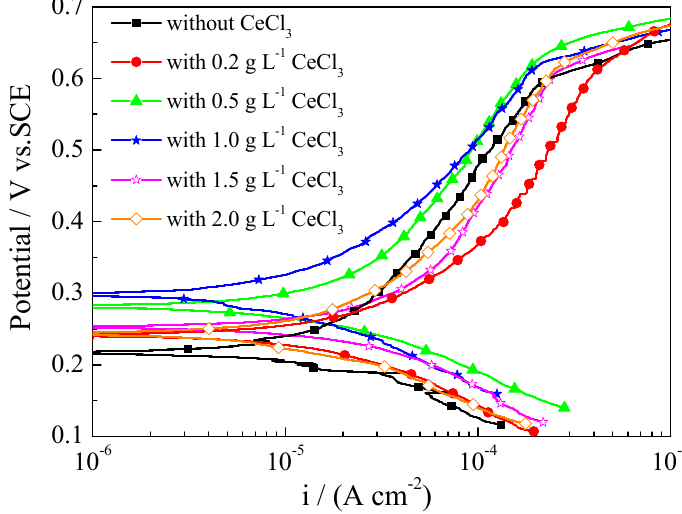
Figure 4. Polarization curves of the plated samples in the solutions with different contents of CeCl 3 . Table 6. The corrosion current density ( i c ) and Corrosion Potential ( E c ) of the electroplated samples that were obtained from polarization curves. CeCl 3 (g L − 1